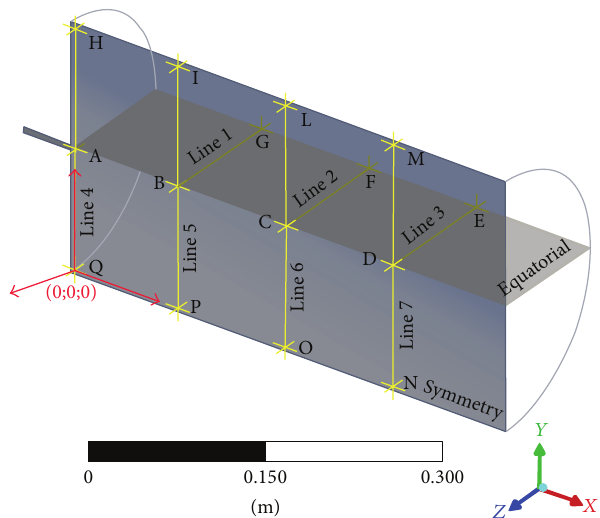
Figure 16: Pressure transducers position inside STARDUST.